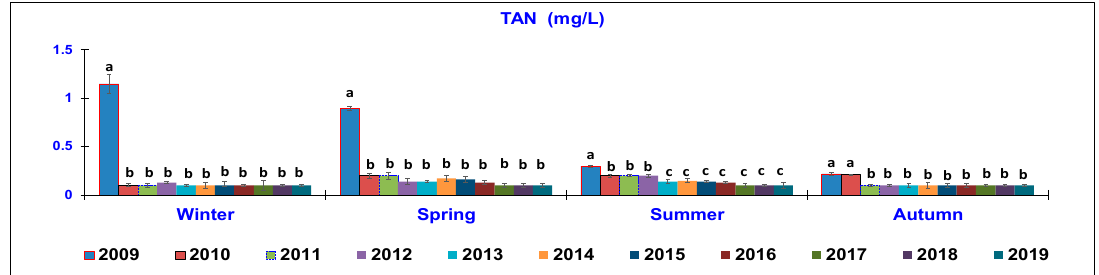
Figure 4. Trend of outlet water Chemical Oxygen Demand (COD) (mg/L) (mean ± standard deviation) seasonally determined during the 10 year-study. Different letters (a, b, c, d) per season show significant differences ( p < 0.05) among the 10 years of sampling.